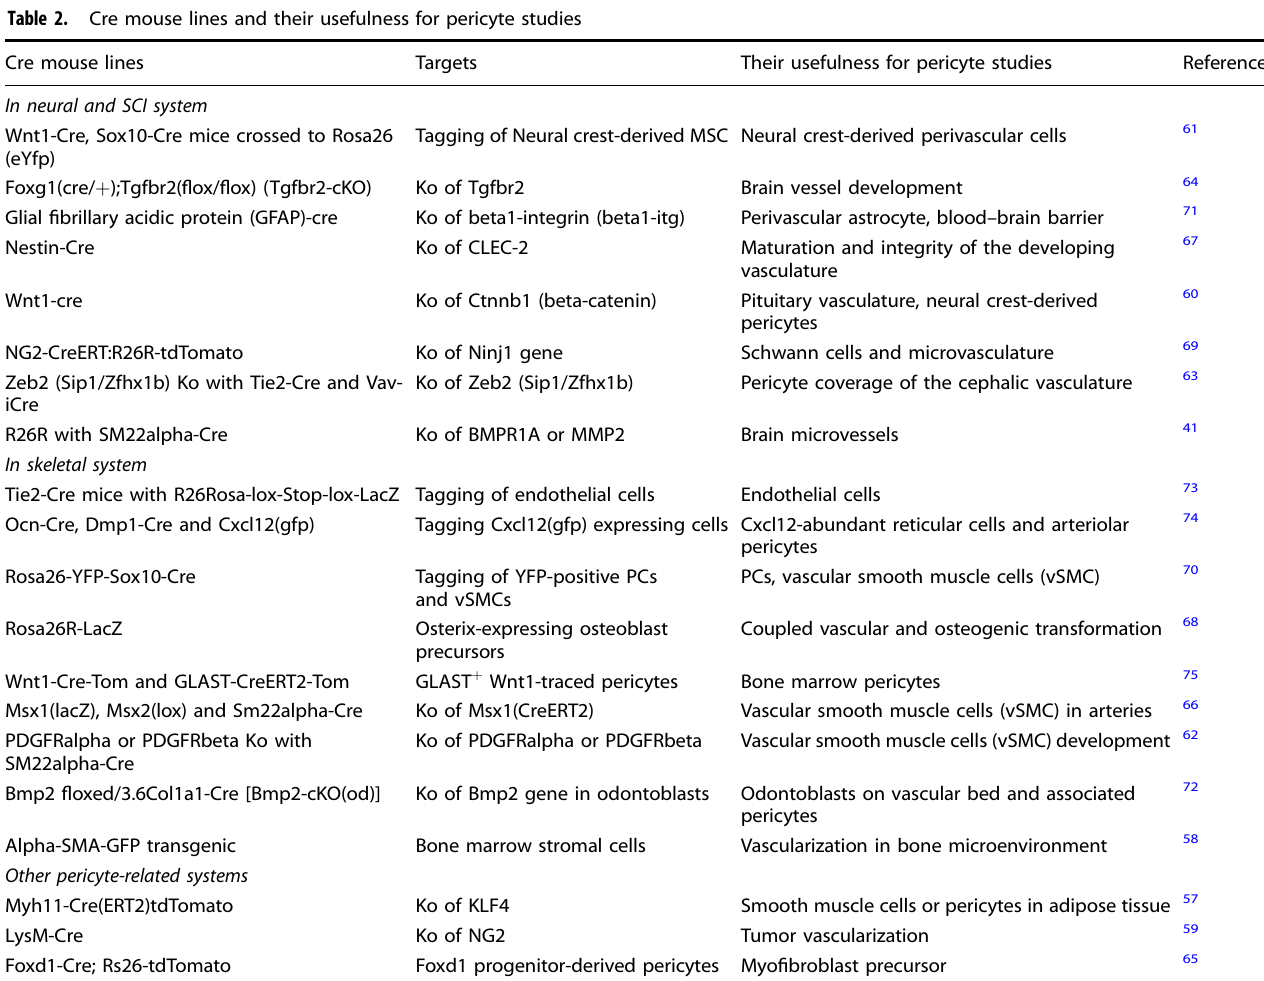
Table 2. Cre mouse lines and their usefulness for pericyte studies Cre mouse lines